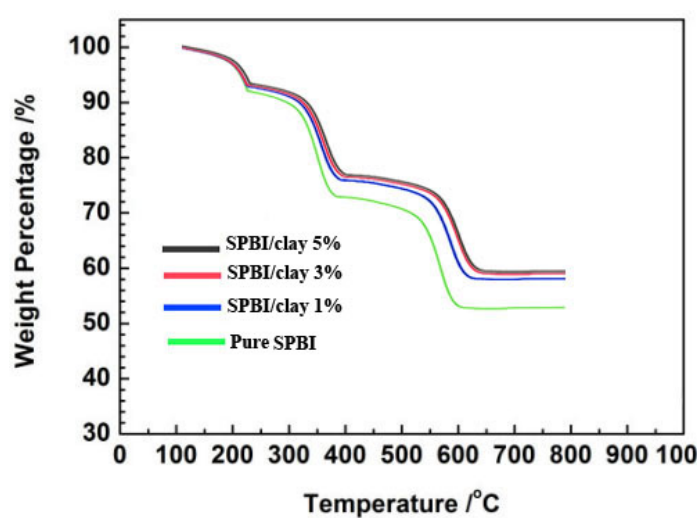
Fig. 7 Fig. 7. TGA thermograms of Pure SPBI and SPBI/clays with different organoclay